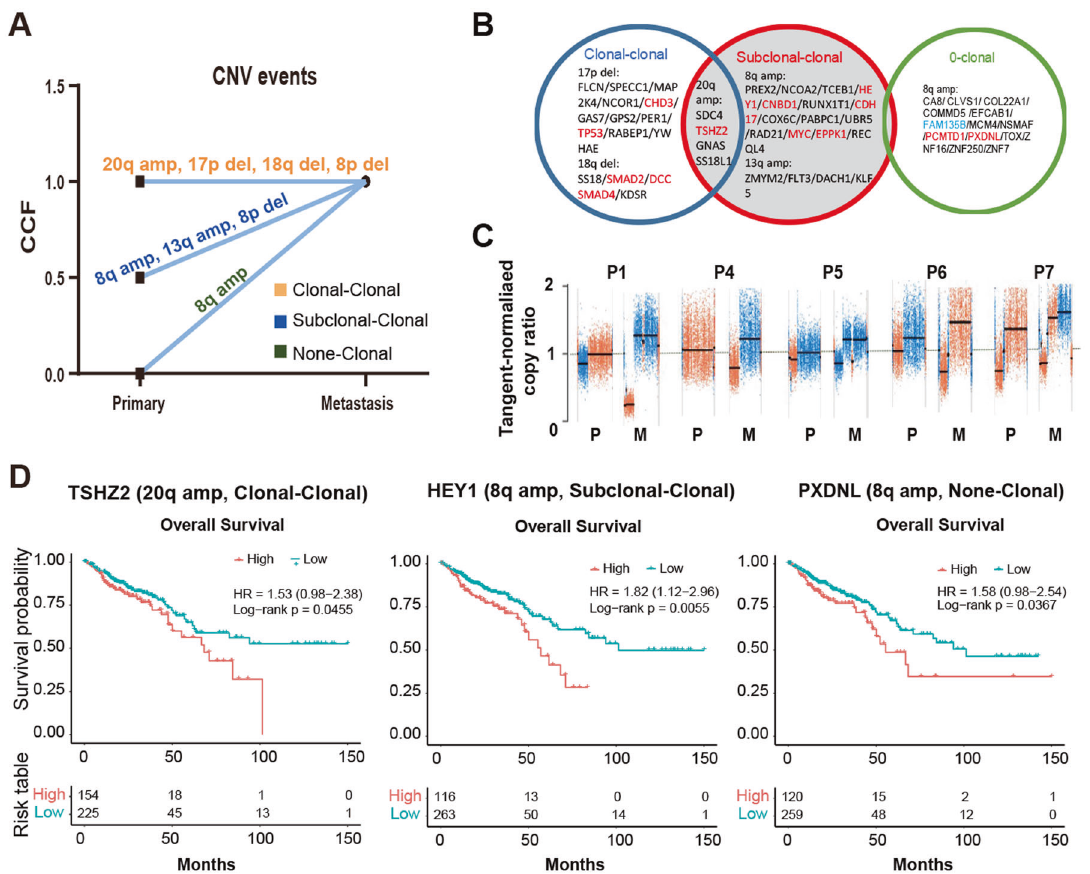
Chromosome 8q in matched primary tumor tissues and metastatic tissue in fi ve patients; copy ratios were calculated by GATK software. D The genes associated with CRC prognosis on segments with CNV events. CNV copy number variation, CLM colorectal liver metastasis, CRC colorectal